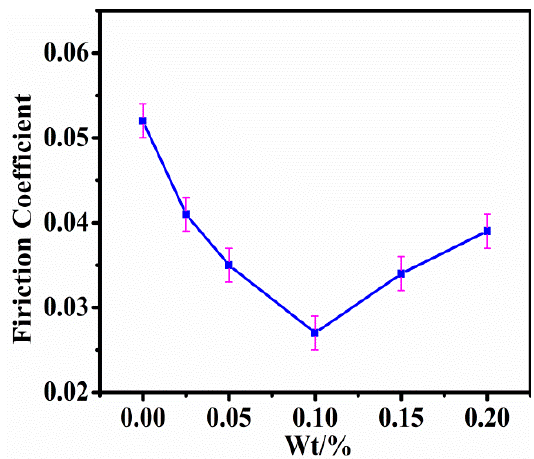
Figure 11. Friction coefficient lubricating by product TiO 2 containing oil at different concentrations.